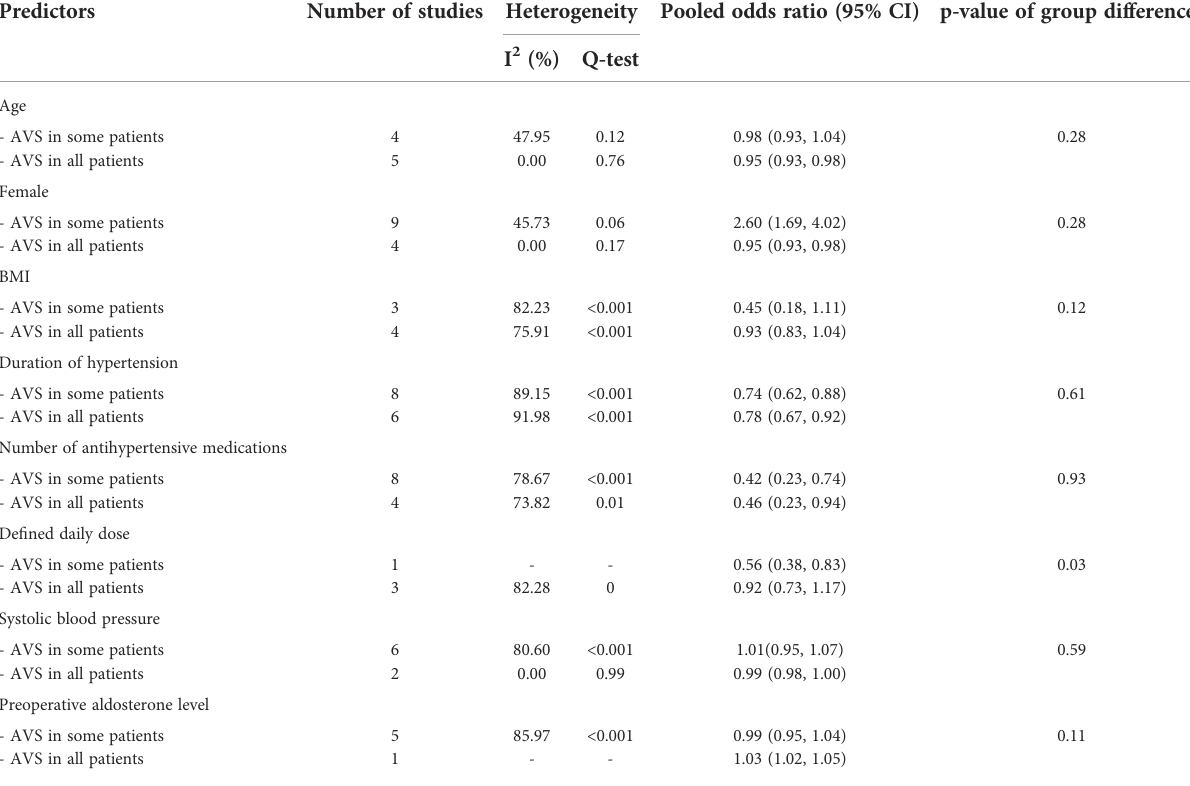
TABLE 4 Subgroup analysis of the predictive factors of clinical success after adrenalectomy in primary aldosteronism by adrenal venous sampling status using fully adjusted odds ratio .